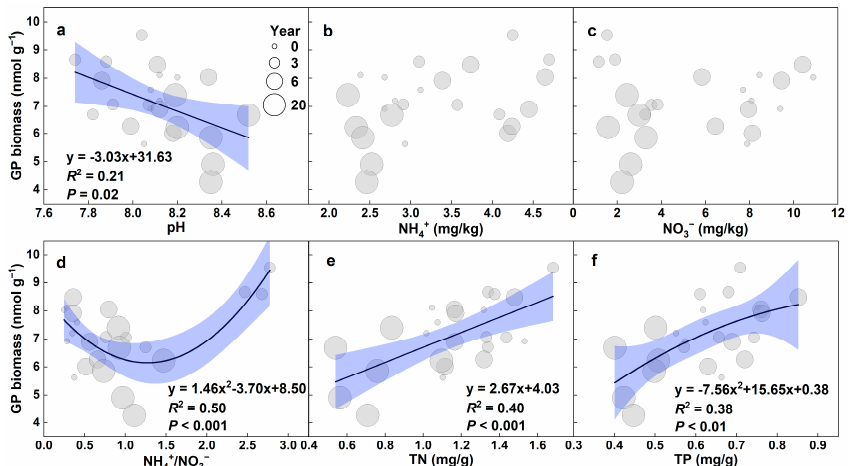
Figure 7. Relationships of Gram-positive bacterial biomass (GP biomass, nmol·g − 1 ) with soil proper- ties (pH, ( a ); NH 4+ , ( b ); NO 3 − , ( c ); NH 4+ /NO 3 − , ( d ); TN, ( e ); TP, ( f )). See abbreviations in Table 2.